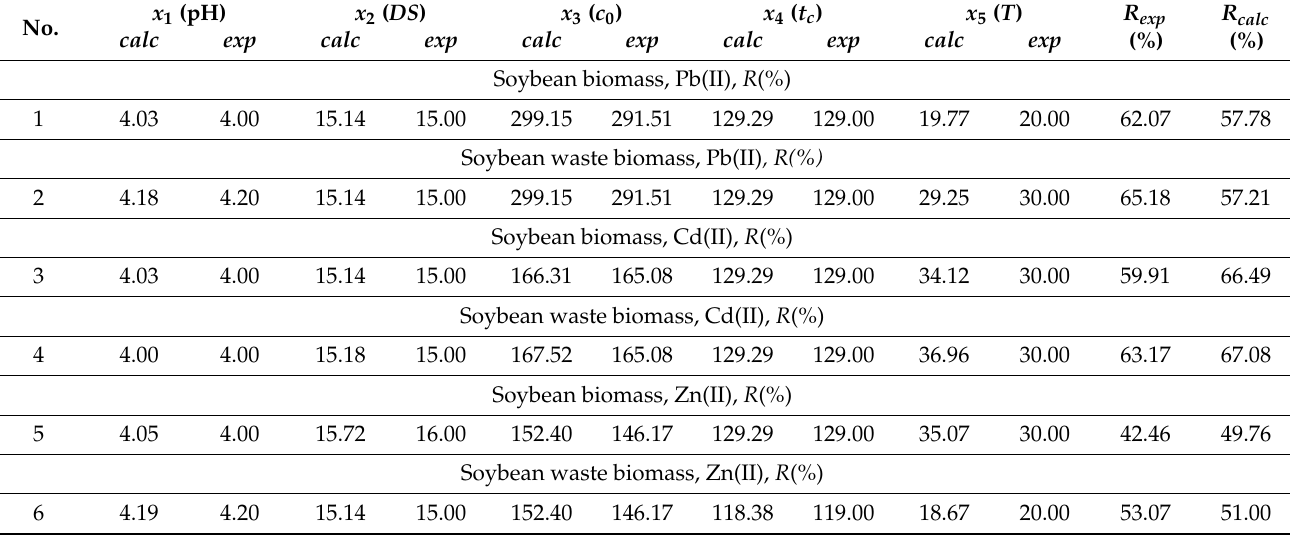
Table 15. Experimental values of R (%) during the validation of the optimal solutions in Table